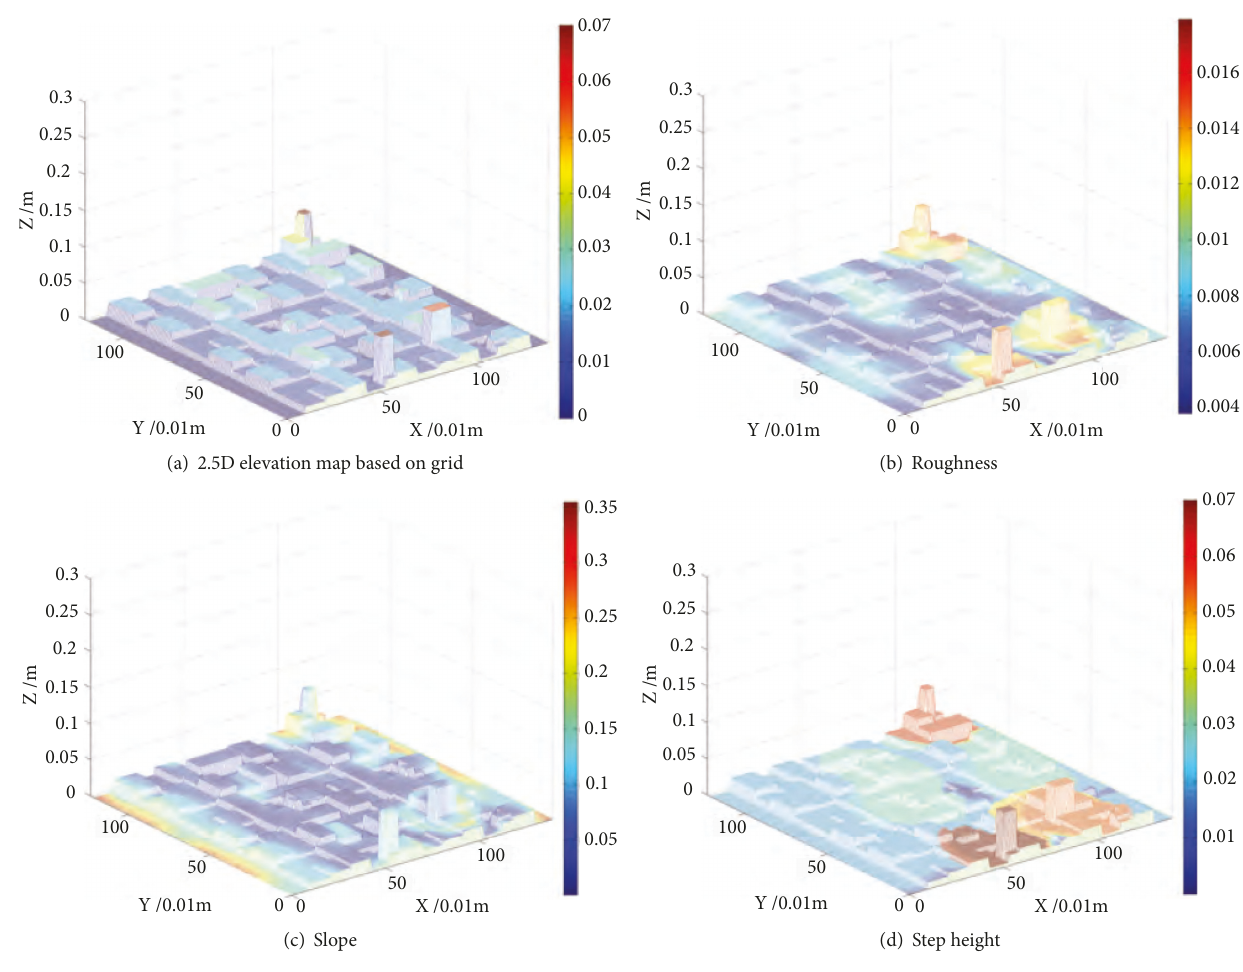
Figure 11: Geometric features of 3D terrain under the robot body. Table 4: The DH parameters for the right legs.